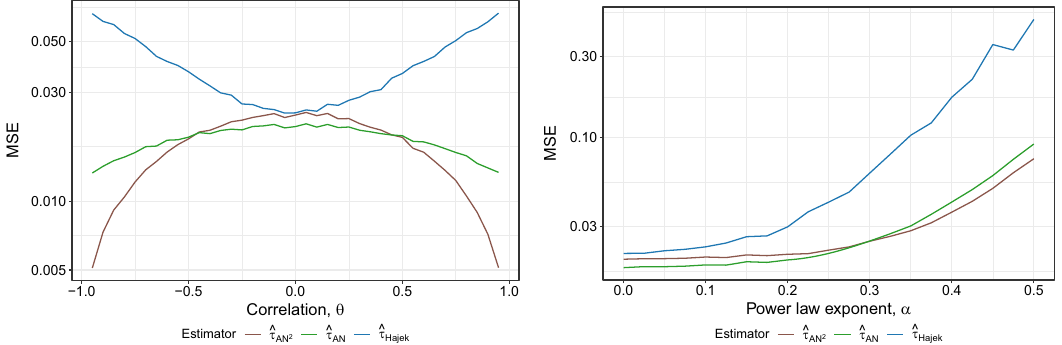
and τ ˆ AN in the normal model with n μ 500, 1 = = ( left ) and power law model with n 500 = ( right ) Figure A3: Comparison of τ ˆ AN 2